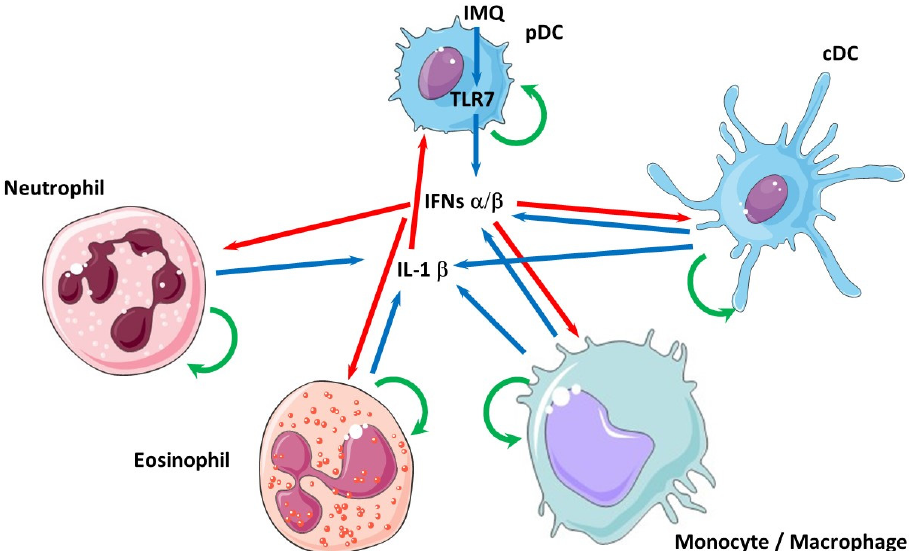
Figure 2. The complex network of interactions between type I IFNs, IL-1 β and the cells that produce them. Simplified representation of the potential interactions between plasmacytoid (pDC) or conventional (cDC) dendritic cell, macrophages/monocytes, neutrophils and eosinophils upon, for example, imiquimod (IMQ) stimulation acting via TLR7 in pDCs. Blue arrows denote cytokine expression, red arrows indicate that these cytokines exert an effect (activation or inhibition) on target cells and green arrows represent retro-control of the cytokines on the cells that produce them.